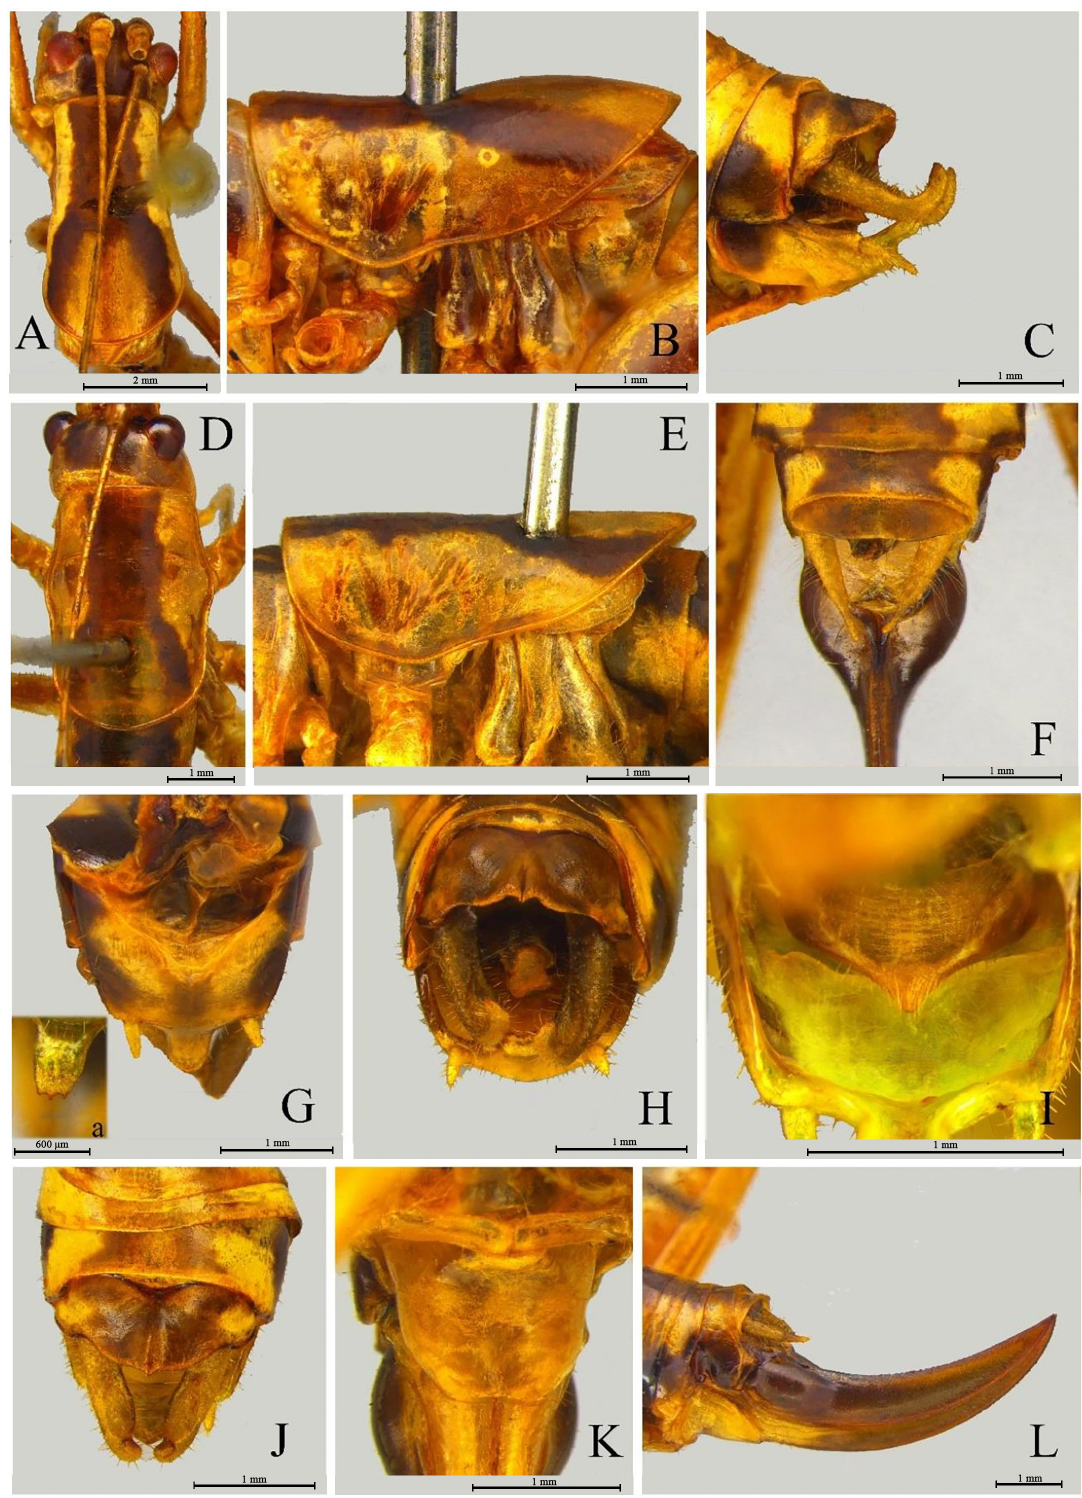
Fig. 1. Acosmetides peltates gen. et sp. nov. A–C, G–J . Holotype, ♂ (HBU). D–F, K–L . Paratype, ♀ (HBU). – A–B, D–E . Pronotum. A, D . Dorsal view. B , E . Lateral view. – C, F–L . Apex of abdomen. C . Lateral view. F, J . Dorsal view. H . Apico-dorsal view. I . Apical area of genitalia in ventral view. G, K . Subgenital plate in ventral view; a = apical area of subgenital plate. L . Ovipositor in lateral